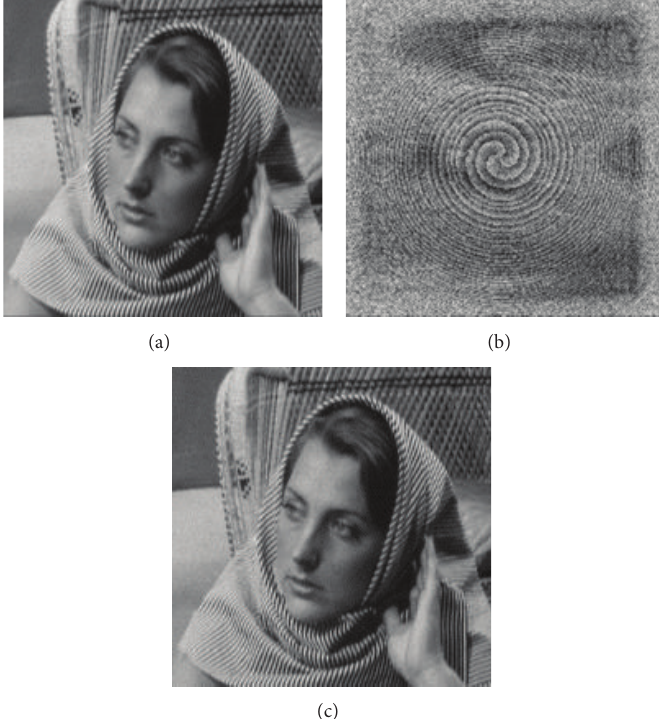
Figure 4: (a) Secret grayscale image with 256 × 256 pixels of Barbara, (b) the corresponding phase key generated by PRA, and (c) retrieved image with correct decryption parameters (𝑆 = 3, 𝜆 = 632.8 nm , 𝑚 = 3, 𝑓 = 4 cm ,𝑝 = 0.3, 𝛼 = 0.7)